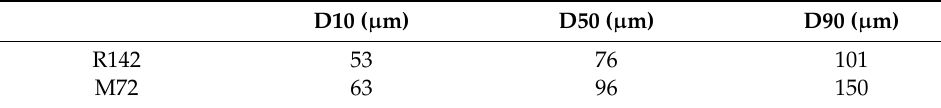
Figure 2. PSD analysis and powder morphology of ( a , b ) R142, and ( c , d ) M72 powders. Table 3. PSD analysis of R142 and M72 powders.